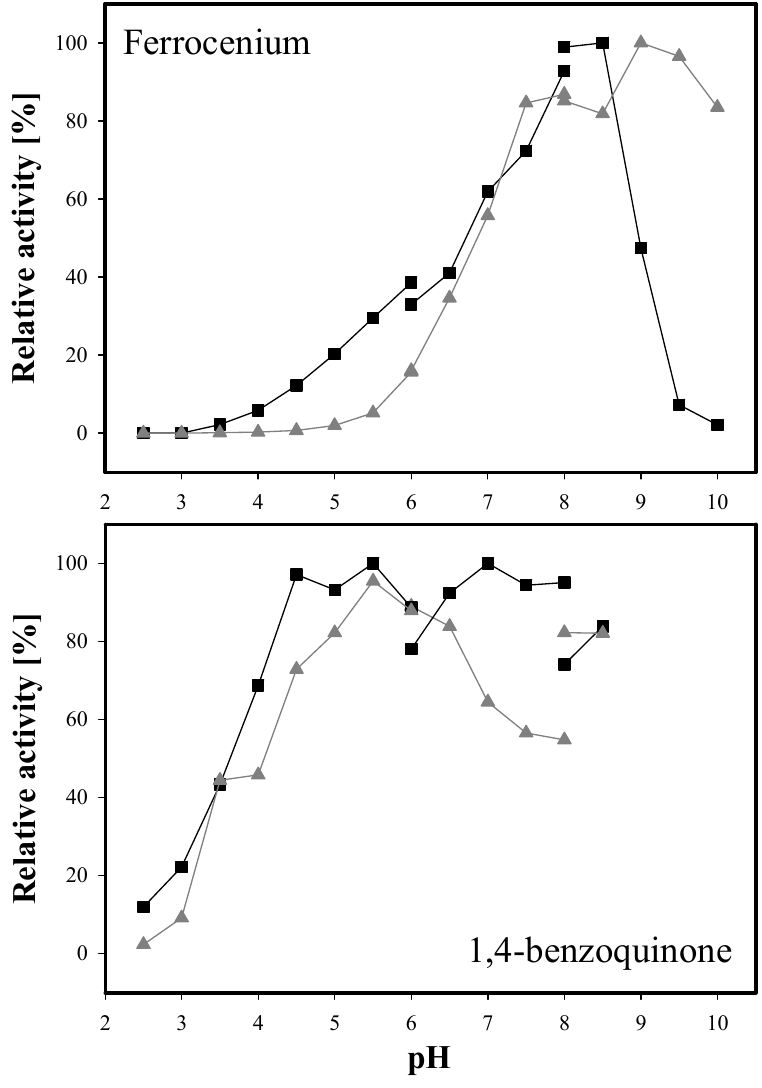
electron acceptors ferrocenium hexafluorophosphate and 1,4-benzoquinone; D -glucose as electron